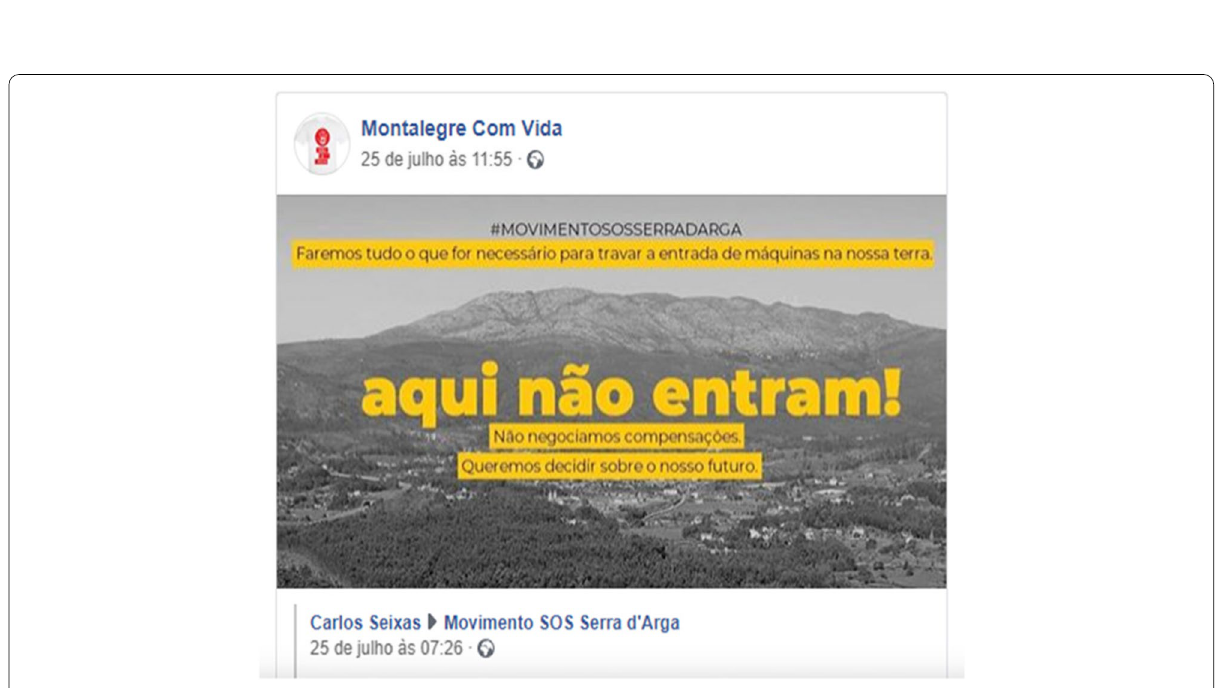
Fig. 3 Facebook content claims, “Here they do not enter: we do no negotiate. We want to decide our future.” Source: